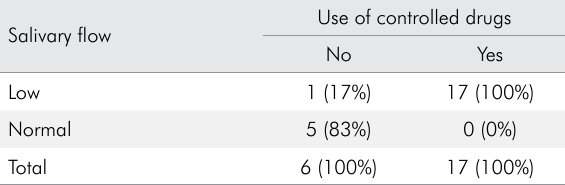
Table 5. Association between the use of controlled drugs and salivary flow (p< 0.0001).